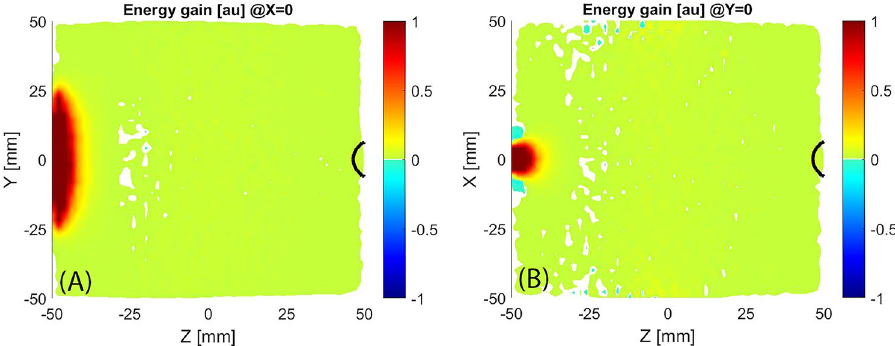
Figure 5. X = 0 and Y = 0 slice views of the energy gain distribution, black line marks the ECR region.